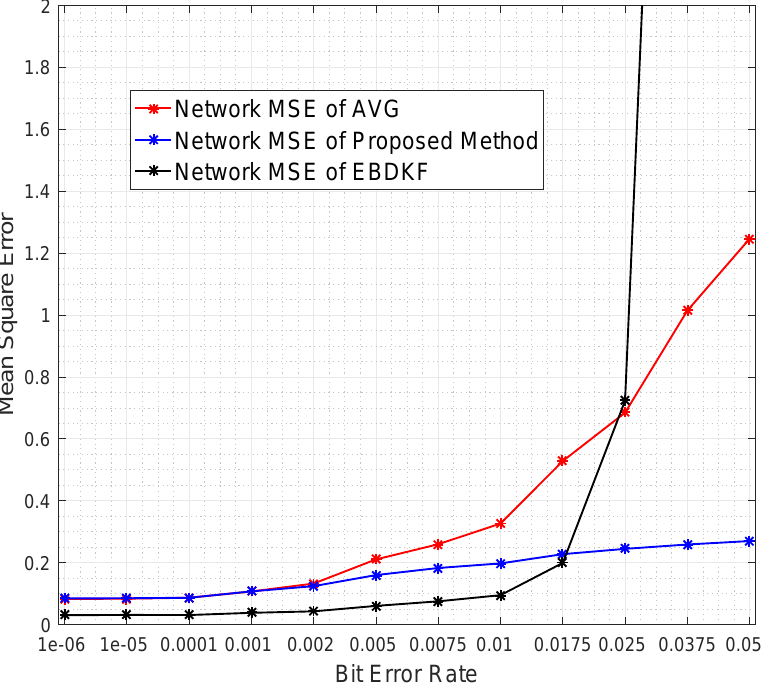
Figure 20. Accuracy comparison of 3 different fusion techniques for an ad hoc-type